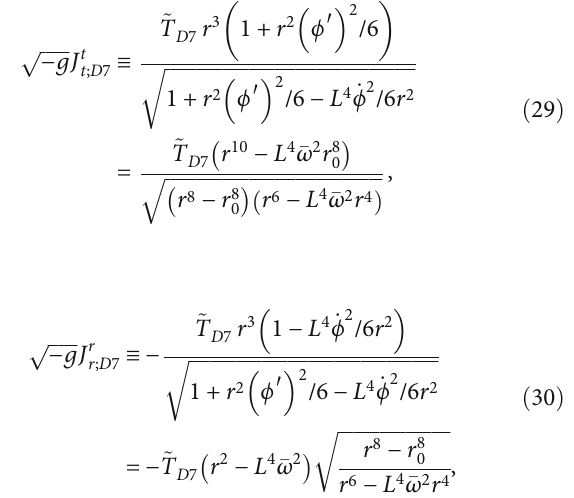
Figure 1: The behavior of the derivative of the D7-brane world volume fi eld with respect to r with L = 1, r (blue-dashed), ω = 8 (gray-dashed), and ω = 10 (black-dashed) (up-left). The behavior of the g world volume metric with L = 1 , r = 0 , ω = 0 (black-solid), r = 3 , ω = 0 (gray-dashed), and r 0 0 behavior of the world volume Hawking temperature of the probe D7-brane with L = 10 and r = 3 : 5 (gray-dashed), r = 3 (blue-dashed) (down-left). The behavior of the energy density of the probe D7-brane with L = ω = 1 and r 0 0 = 4 (black-solid), r = 6 (blue-dashed), and r = 8 (gray-dashed) r 0 0 0